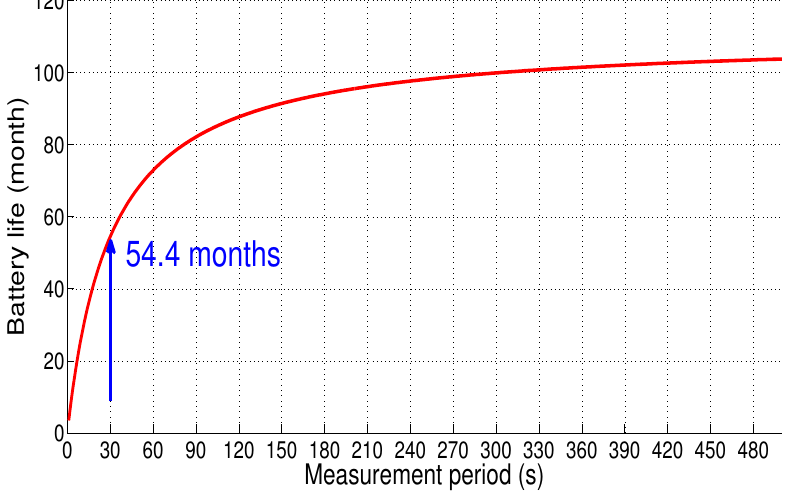
Figure 18. Sensor node autonomy: Scenario